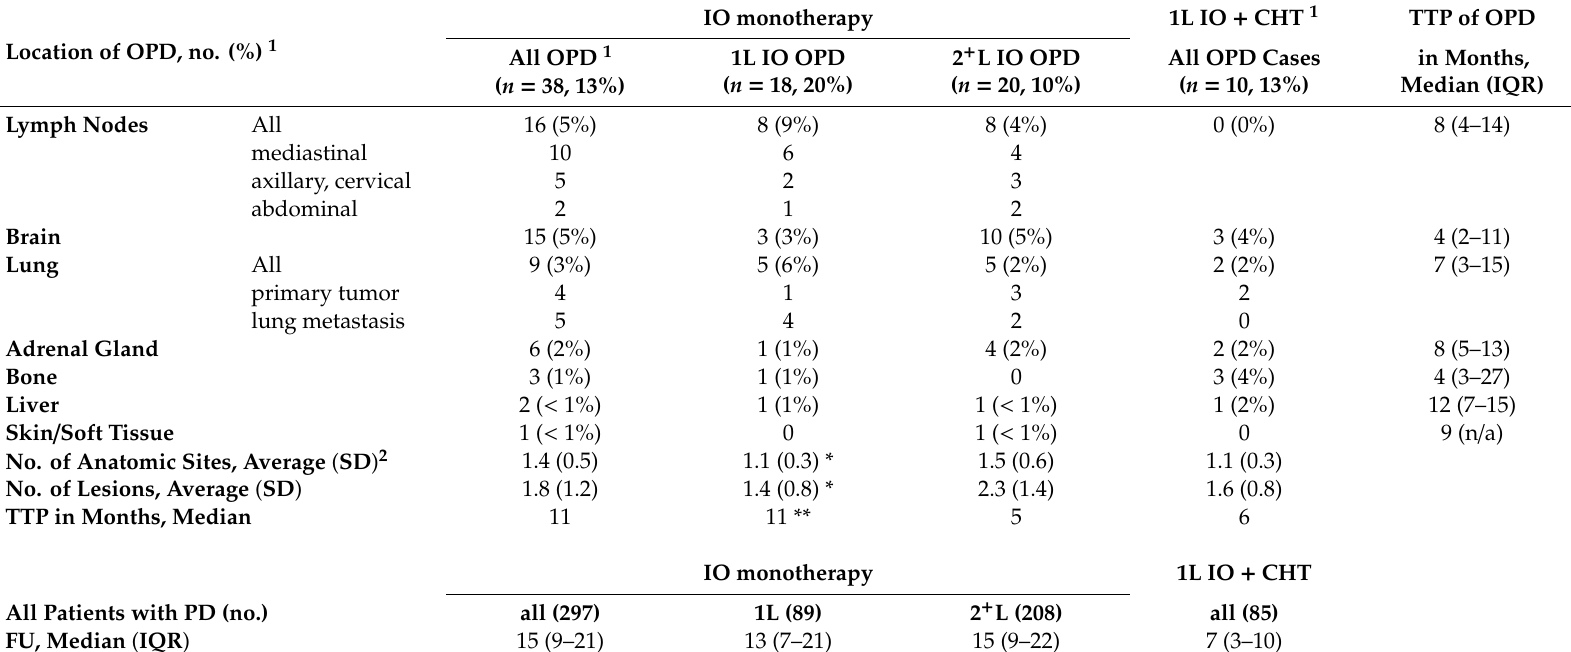
Table 2. Frequency and anatomical distribution of oligoprogression in IO-treated